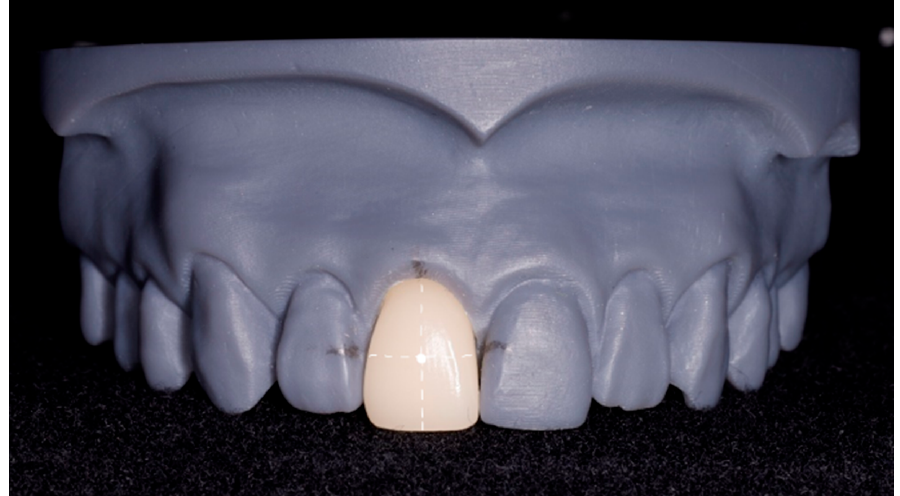
Figure 3. A gray resin model with milled right central incisor and the shade measuring point.